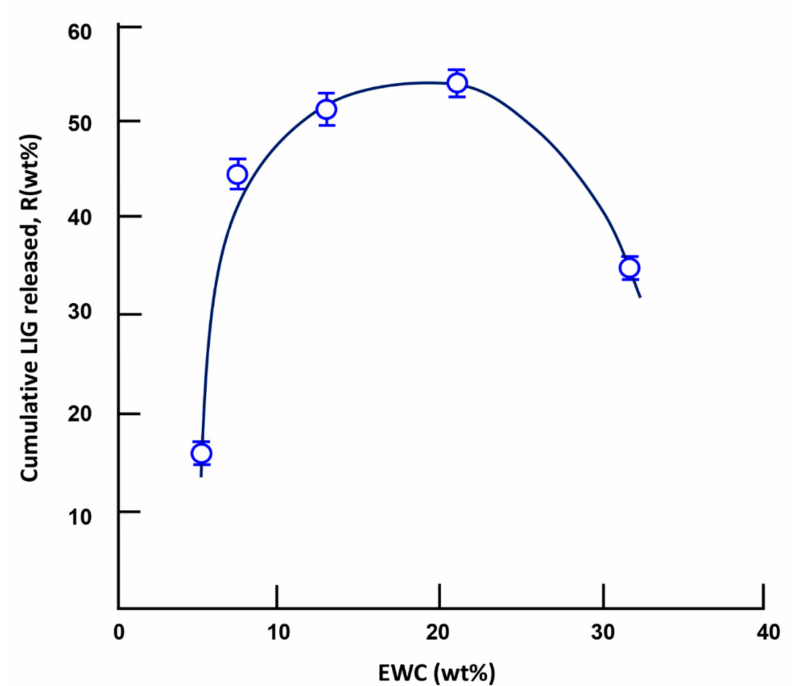
Figure 15. Variation of the cumulative lignocaine released versus the water content at equilibrium during the 3-day release process.